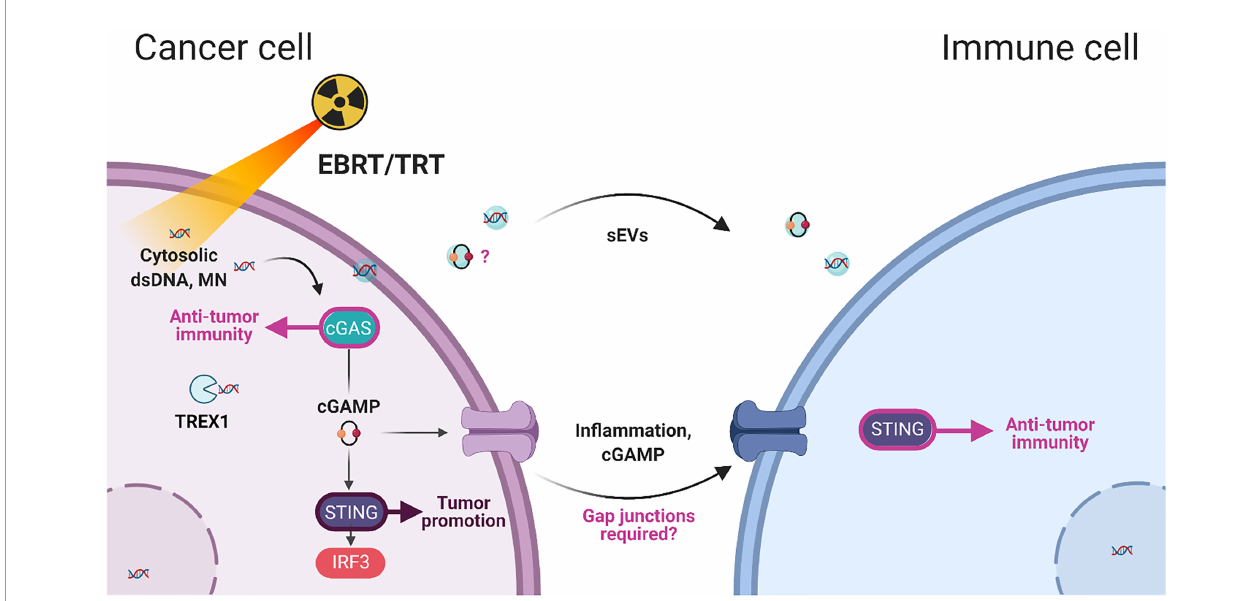
FIGURE 1 | Summary of cancer-immune cell interactions after irradiation (EBRT, external beam radiation therapy; TRT, Targeted Radionuclide Therapy) and the involvement of dsDNA,double-stranded DNA; MN, micronucleus; sEVs, small extracellular vesicles; and cGAMP, cyclic GMP – AMP in bystander